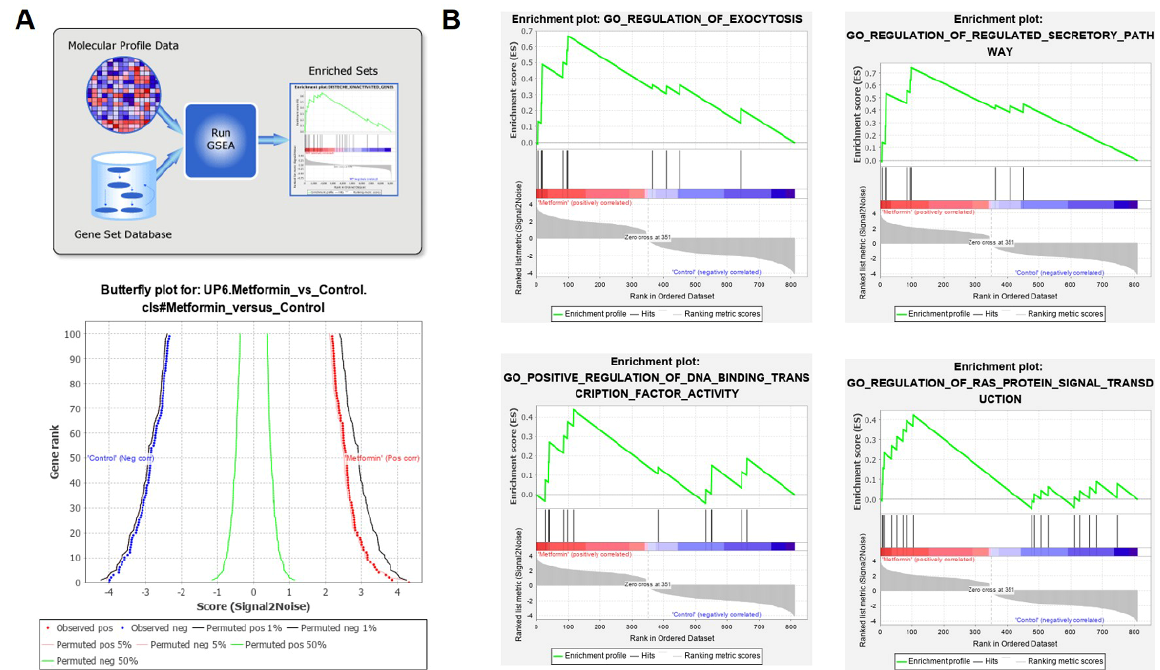
Figure 4. Gene set enrichment analysis (GSEA) of metformin responsive-genes in macrophages. ( A ) The work flow chart of GSEA and butterfly plot for metformin responsive-genes in macrophages. ( B ) Enrichment plots for regulation of exocytosis, regulation of regulated secretory pathway, positive regulation of DNA binding transcript factor activity and regulation of RAS protein signal transduction in the data set. The plots contain the enrichment score (ES) and positions of GeneSet members on the rank-ordered list. The X axis represents the rank-ordered dataset and the Y axis represents the enrichment score (ES).